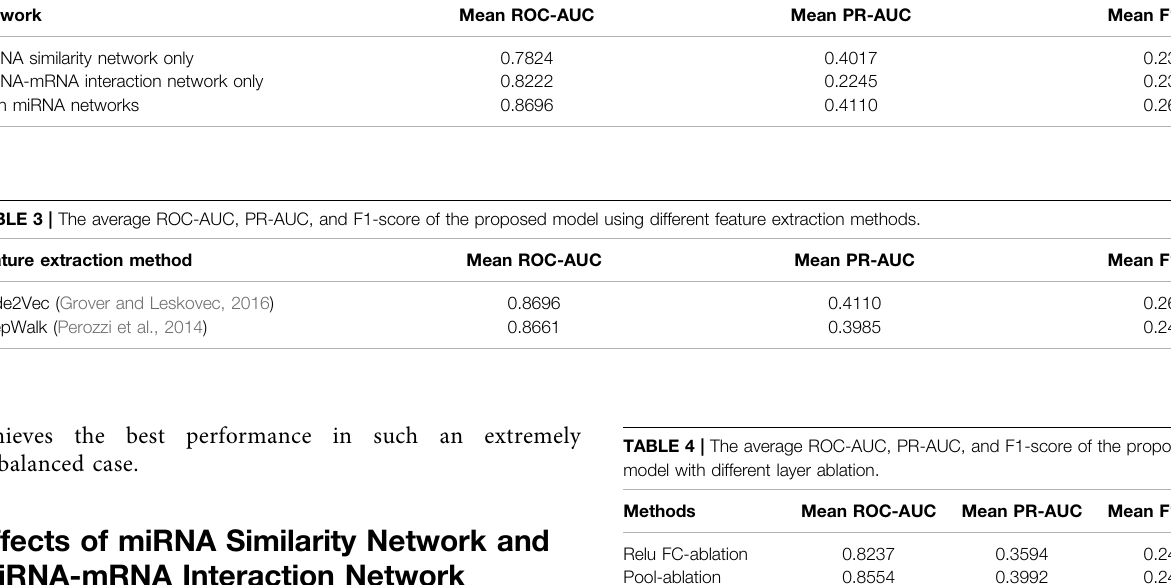
TABLE 2 | The average ROC-AUC, PR-AUC, and F1-score of the proposed model using different network features. Network Mean ROC-AUC miRNA similarity network only